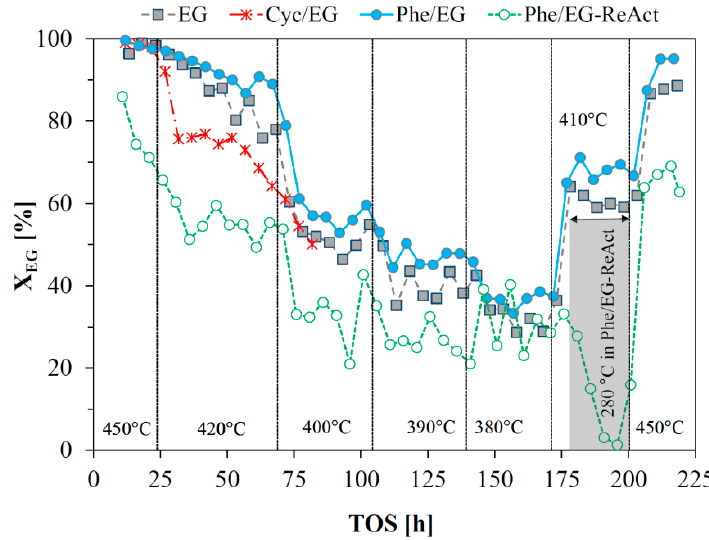
Figure 1. Conversion of ethylene glycol, X EG , from experiments with pure ethylene glycol and mixtures of cyclohexanol/EG and phenol/EG, and with the phenol/EG mixture after catalyst reactivation (Phe/EG-ReAct, see Section 2.4). Set point temperatures are shown. For Phe/EG-ReAct, the step at 390 °C was extended by 15 h (not indicated in the figure for simplicity), until a step at 280 °C was introduced.